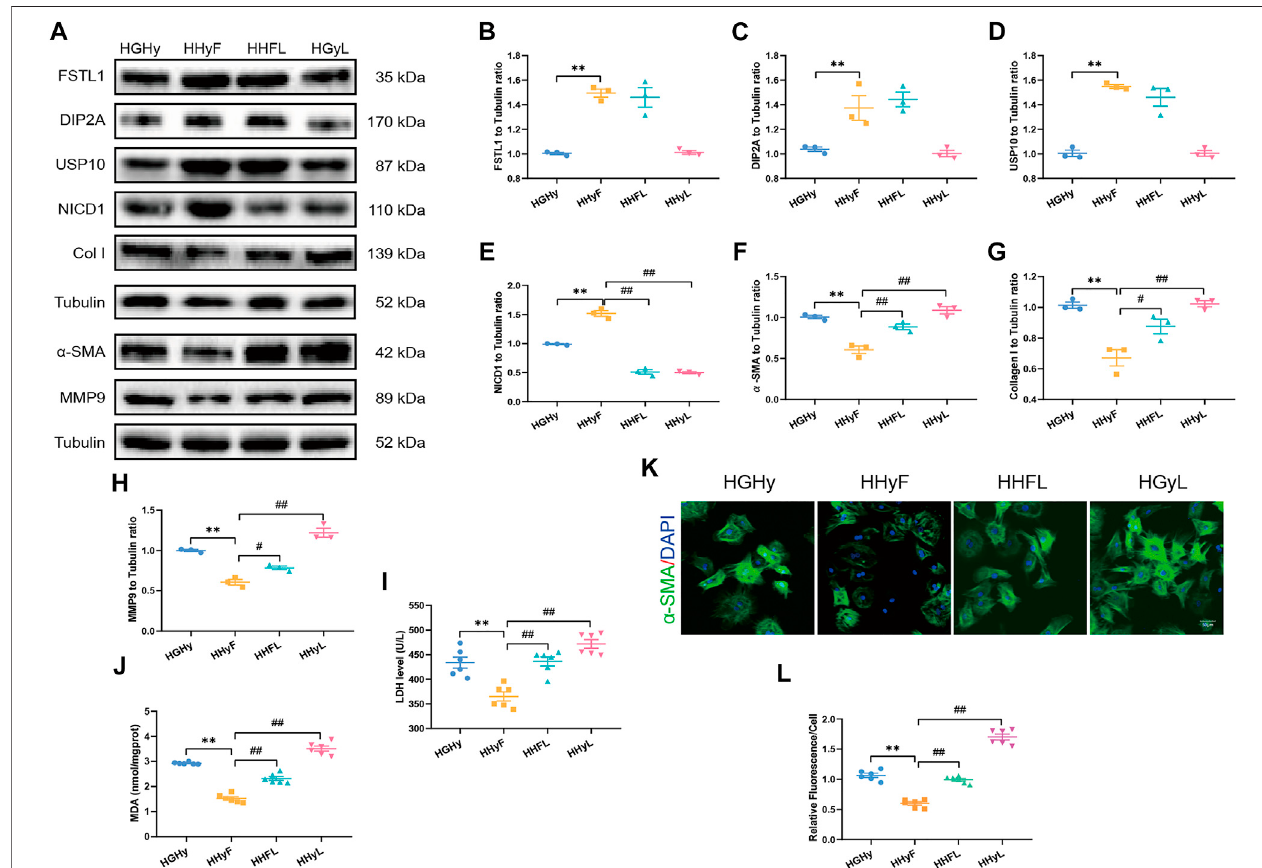
FIGURE6| Levels ofFSTL1,UPS10 and myocardial fi brosis related proteinsinCFs isolated fromT2DM mice post-notch1 inhibition. (A) Representativeimages of Westernblot in CFs isolated from T2DM; (B) FSTL1 level; (C) DIP2Alevel; (D) USP10 level; (E) NICD1 level; (F) α -SMA level; (G) Collagen Ilevel; (H) MMP9 level; (I) LDH level; (J) MDA content; (K) Immuno fl uorescence staining of α -SMA; nuclei are marked by Hoechst 33342 staining; scale bar (cid:2) 50 μ m; Green fl uorescence represents α -SMApositivenuclei;DAPI:blue fl uorescencerepresentstotalCFsnuclei;and (L) Quanti fi cationof α -SMAstaining.HGHy:isolatedCFsweretreatedwithdimethyl sulfoxide (DMSO) as control; HHyF: isolated CFs were treated with 50 ng/ml recombinant Fstl1 protein for 6 h; HHFL: isolated CFs were treated with crenigacestat (LY3039478, 10 μ M) 18 h before recombinant Fstl1 protein administration, and then co-cultured for 6 h; HHyL: isolated CFs were treated with crenigacestat for 24 h. The results are presented as Mean ± SEM, n (cid:2) 3 – 6 in each group. ** p < 0.01.